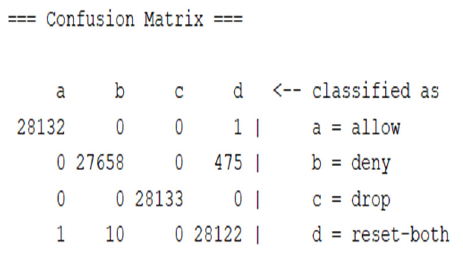
Figure 7. Confusion matrix for RF algorithm in the second experiment.